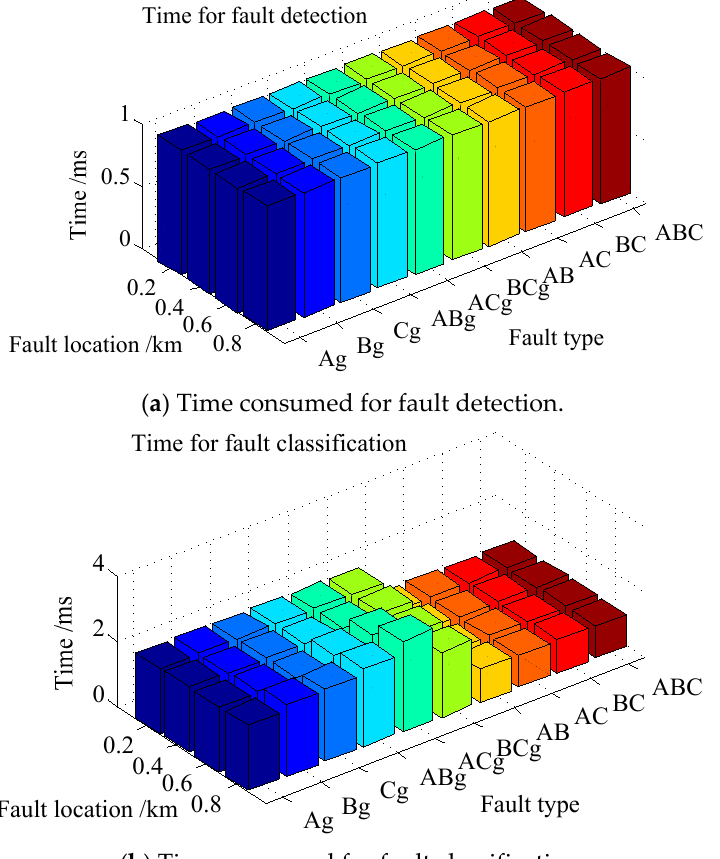
Figure 7. Simulation result of the double-ended power supply section.